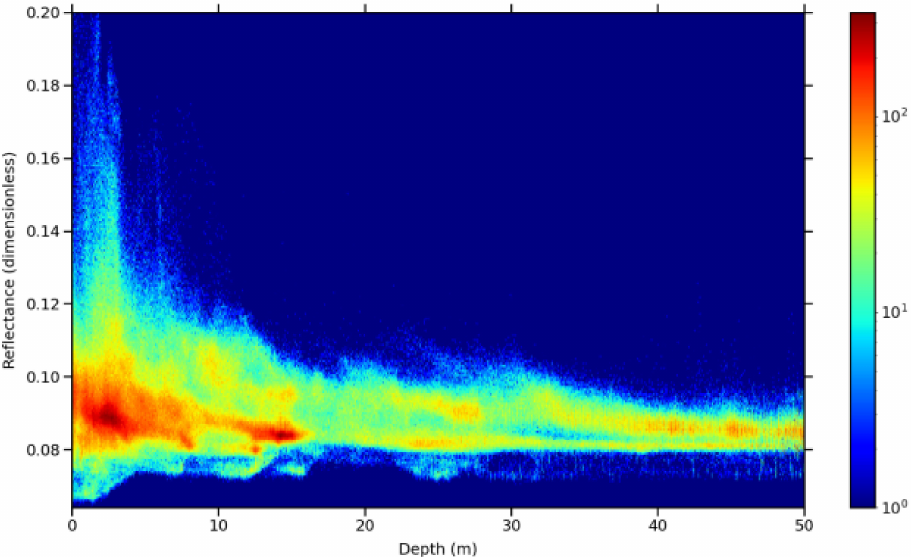
Figure 6. A depths density profile against 490 nm spectral reflectance. Sentinel-2 time series—Guadeloupe